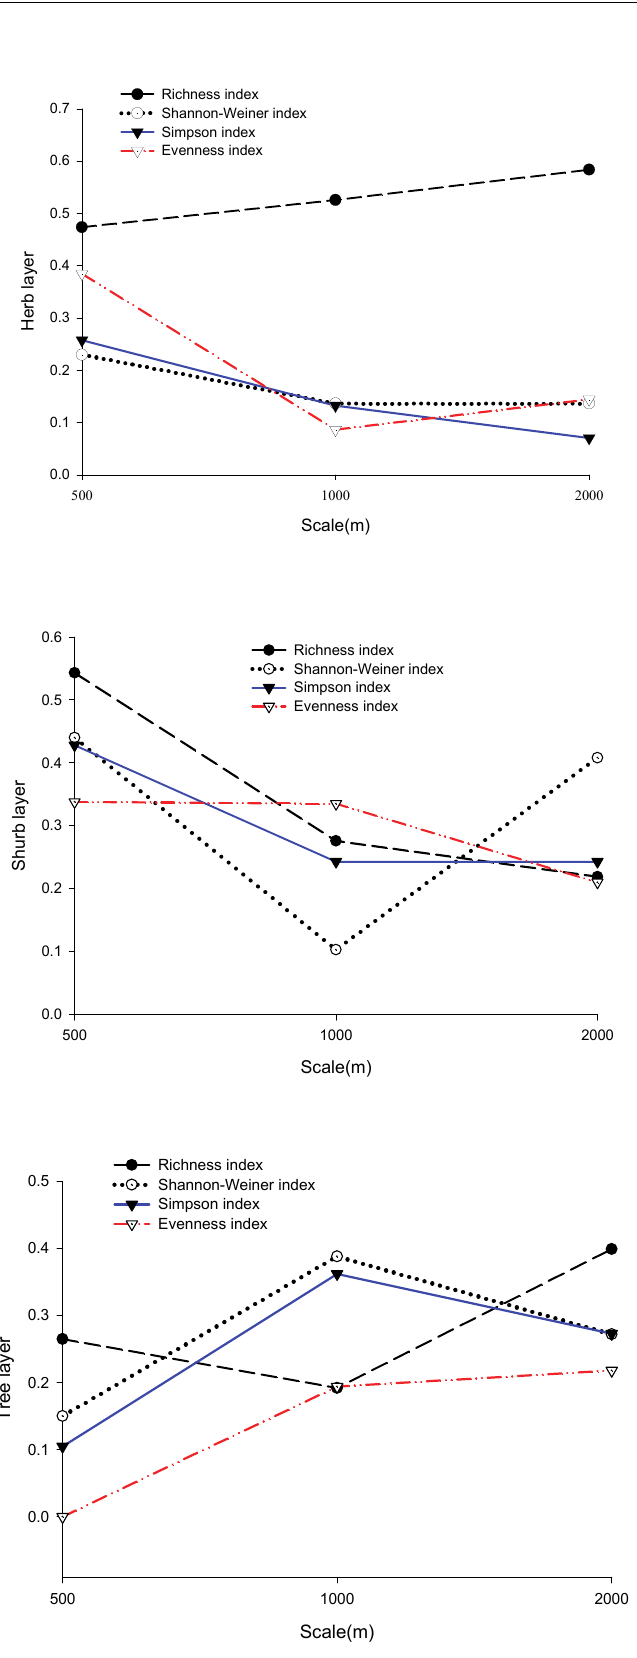
Figure 3. The explanatory power of landscape heterogeneity, community structure, and topographic factors on biodiversity and richness